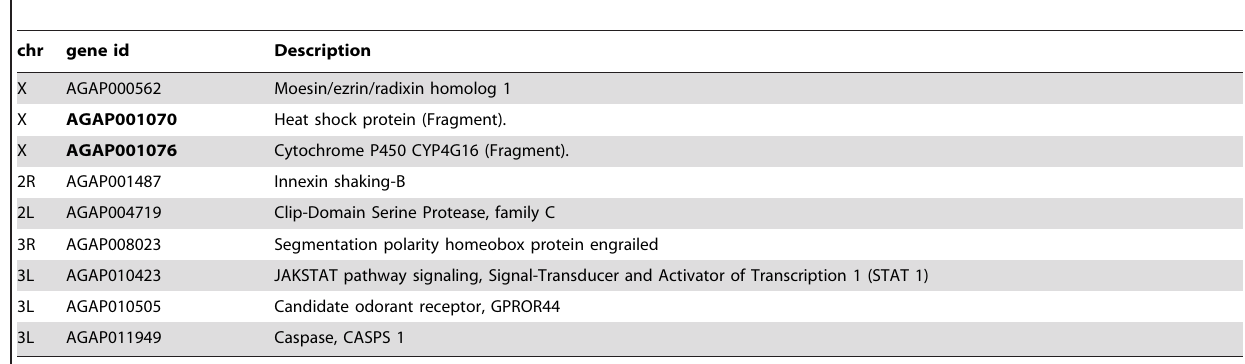
Table 4. Selected list of known genes of which exons overlap with